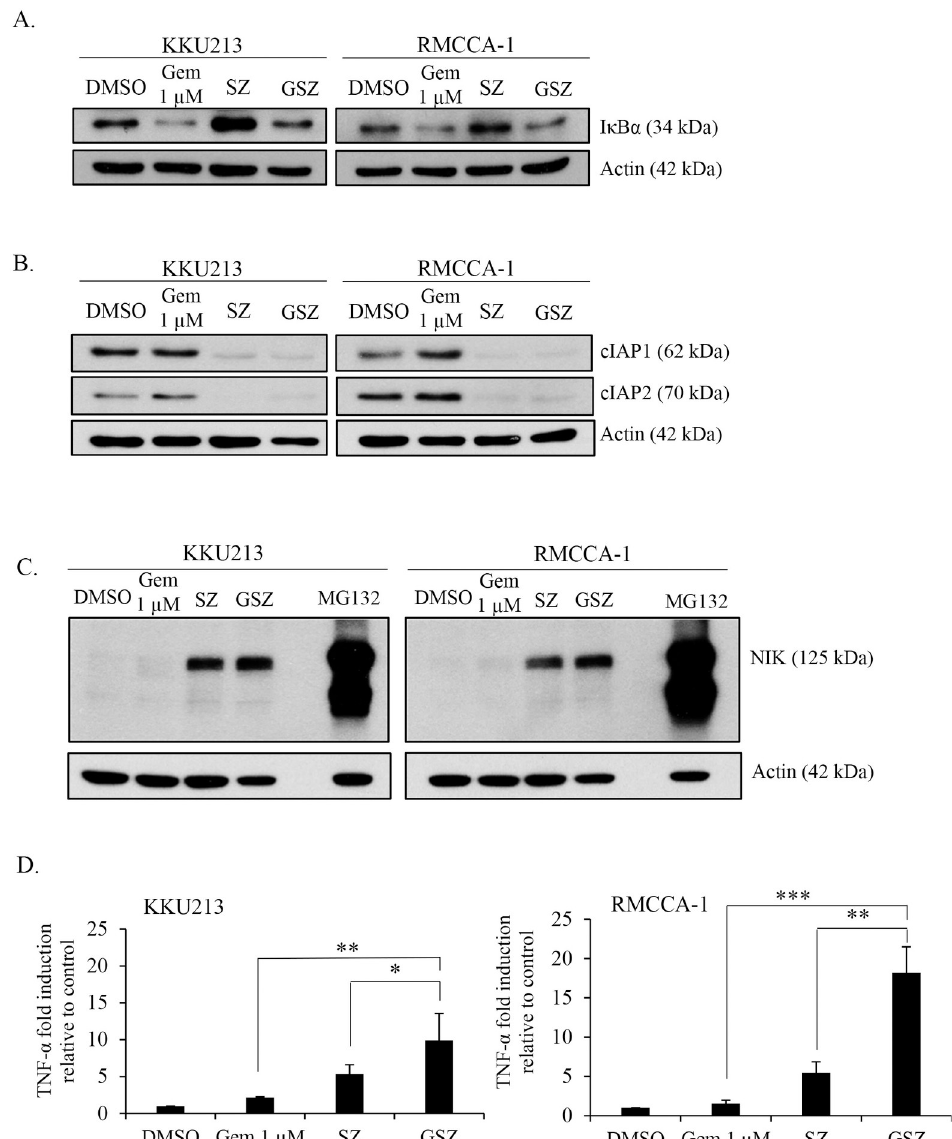
Fig 5. Smac mimetic and gemcitabine synergistically induce TNF- α mRNA levels upon caspase inhibition. KKU213 and RMCCA-1 were treated with DMSO, 1 μ M gemcitabine (Gem 1 μ M), 5 nM Smac mimetic and 20 μ M zVAD-fmk (SZ), or GSZ for 24 h. The expression of I κ B α (A), cIAP1, cIAP2 (B), and NIK (C) were determined by Western blot analysis. MG132 (10 μ M, 6 h) was used as a positive control for NIK stabilization. β -actin served as loading control. (D) Cells were treated as in A, Total RNA was extracted and analyzed for TNF- α mRNA levels by realtime PCR. Data were normalized to GAPDH levels and are expressed as fold induction of treated cells over untreated cells (DMSO). Results shown are the average of triplicate measurement ± S.D. and obtained from two independent experiments; � p < 0.05, �� p < 0.01, ��� p < 0.001.